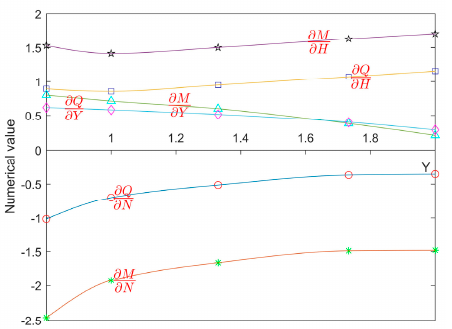
Figure 4. The transform curves of the transfer coefficients with respect to the guide vane opening Y ( N = 1, H =